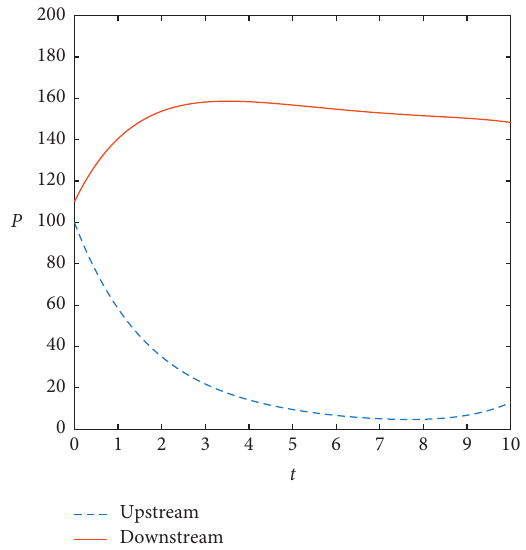
Figure 13: Optimal trajectory of pollution stock under non-co- operation when T � 10.